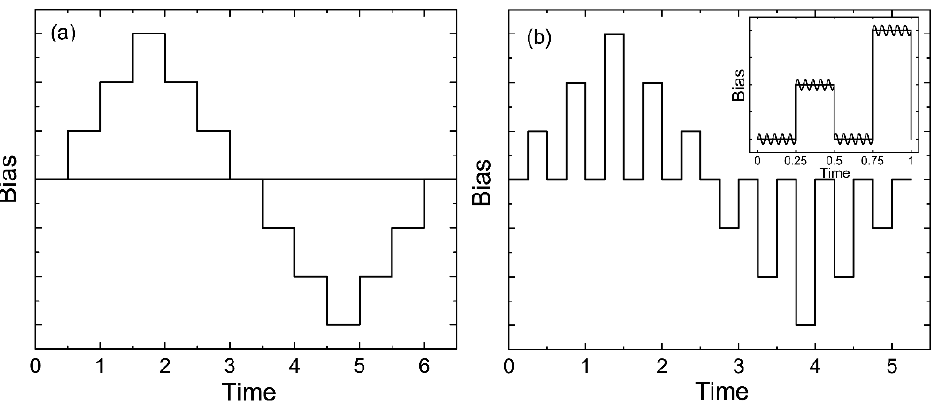
Figure 2. Schemes for obtaining hysteresis loops in two modes — in-field ( a ) and off-field ( b ).